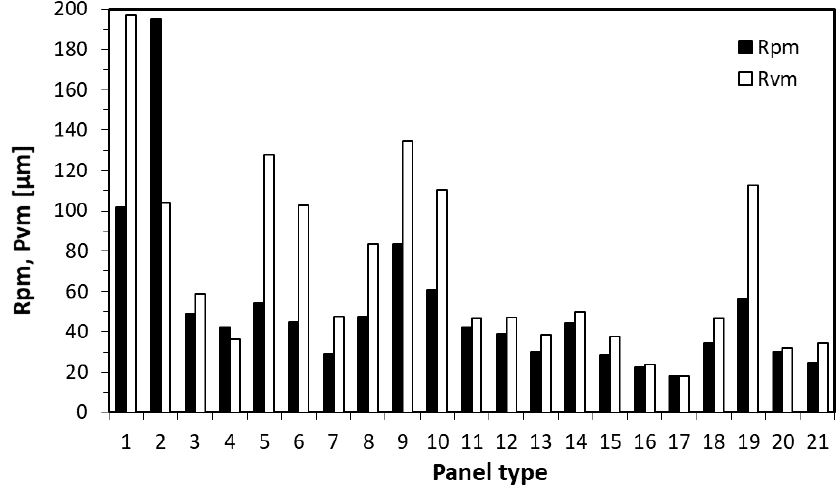
Figure 8. The values of peaks and valley surface roughness of tested composites.